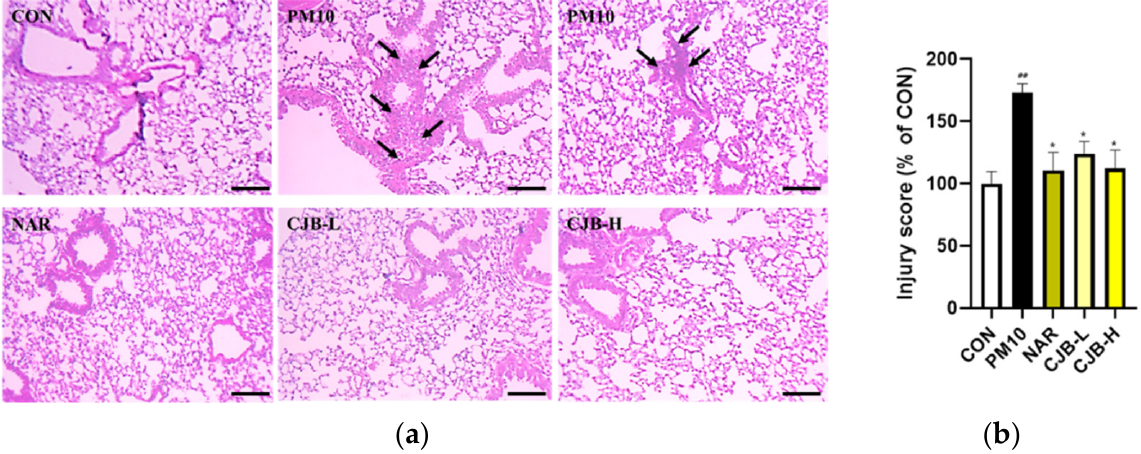
Figure 2. Histological analysis of representative hematoxylin and eosin-stained lung sections and lung pathology assessment of PM10-induced lung damage. ( a ) hematoxylin and eosin-stained sections and ( b ) injury score quantification. Scale bar = 100 μ m (magnification, ×100). All values are expressed as the mean ± SEM. A p -value under 0.05 was considered statistically significant. ## indicates statistical significance compared to the CON group, and * indicates statistical significance compared to the PM10 group. CON, normal control; PM10, negative control; NAR, naringin at 100 mg/kg; CJB-L, CJB at 100 mg/kg; CJB-H, CJB at 200 mg/kg.